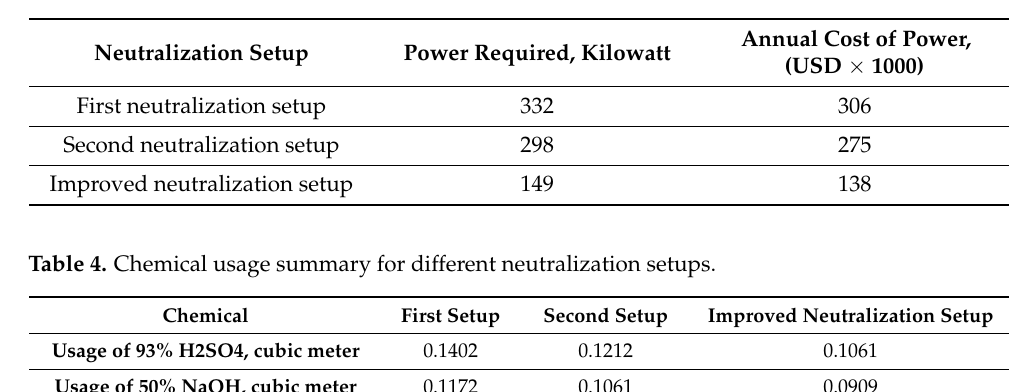
Table 3. Operating cost comparison of running the different neutralization setups.